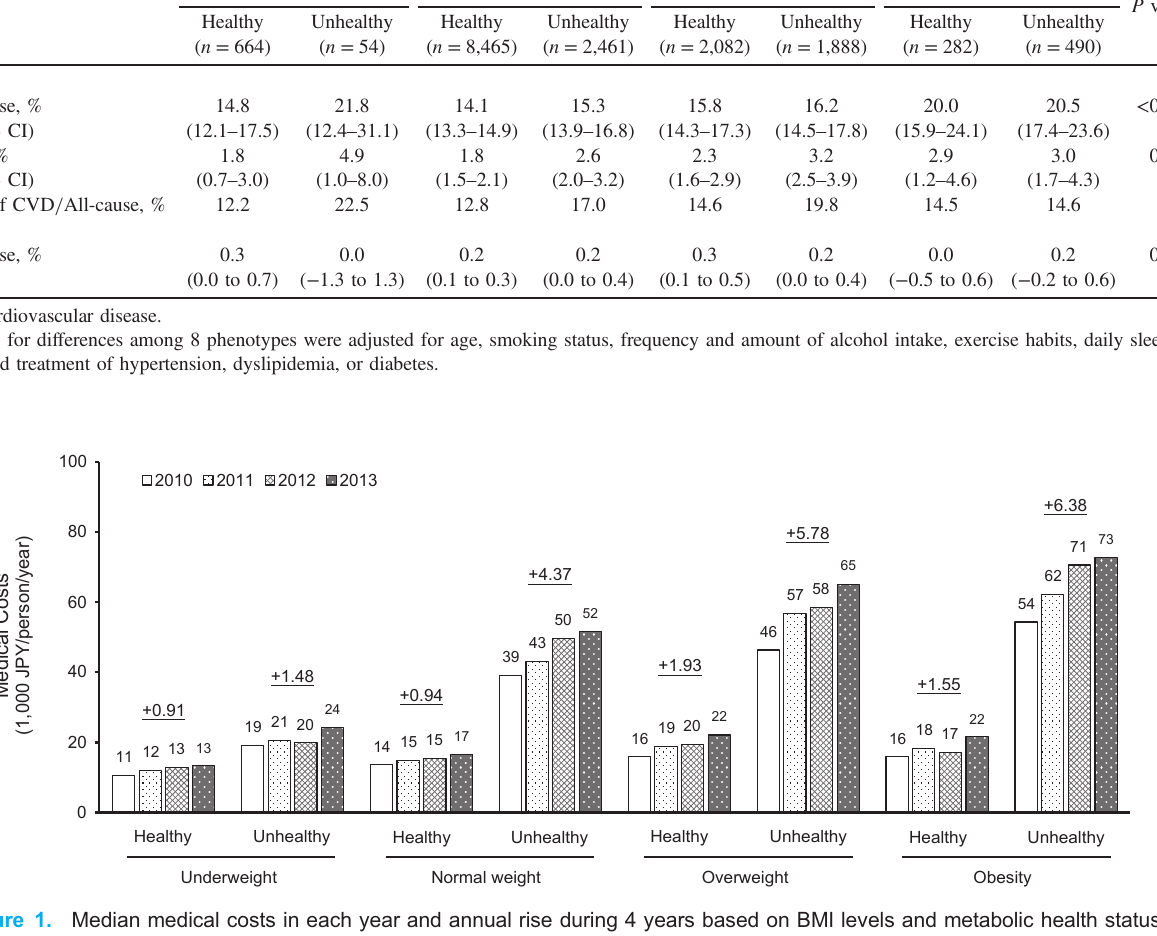
Table 4. 4-year cumulative occurences of medical hospitalization for di ff erent BMI and metabolic phenotypes Underweight